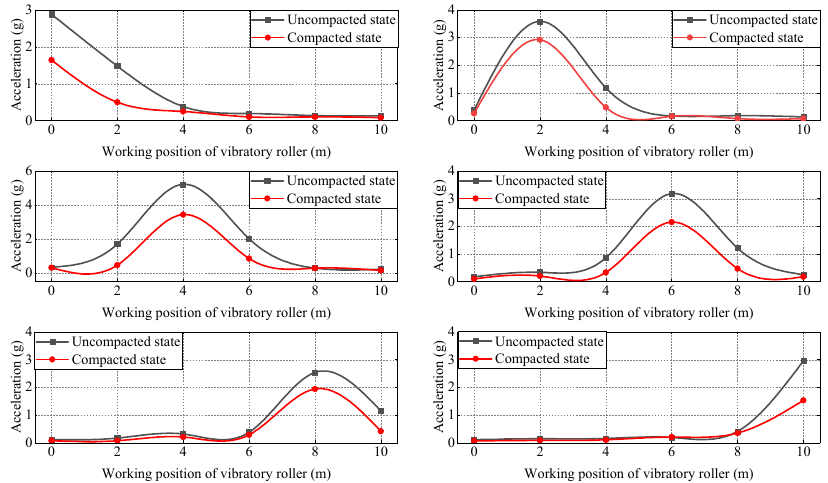
Figure 7. Peak acceleration attenuation curve.